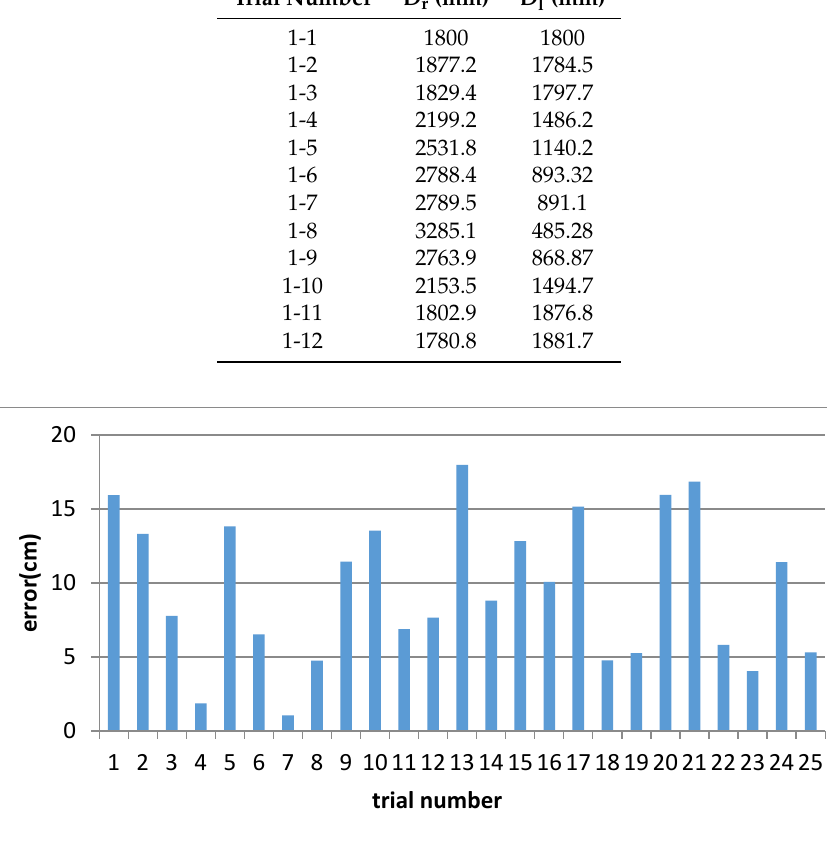
Table 2. Result of self-localization.